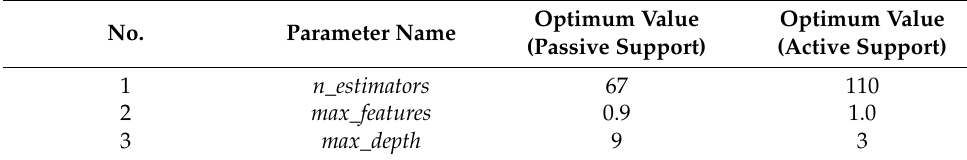
Table 6. GSCV-RF Model Parameter Optimization